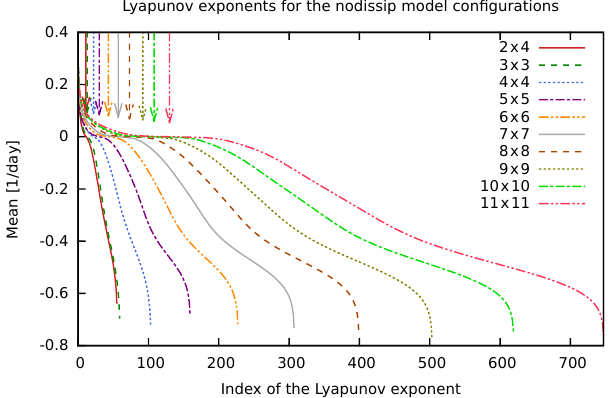
Figure 11. Lyapunov spectra of MAOOAM for the “nodissip” ex- periment, for model configurations from atm. 2 × 4, oc. 2 × 4 (red full line) up to atm. 11 × 11, oc. 11 × 11 (pink dash-dot-dotted line). Lyapunov exponents are ranked in decreasing order, and the in- dex of the smallest positive Lyapunov exponent is indicated with a downward-pointing arrow for each model configuration.